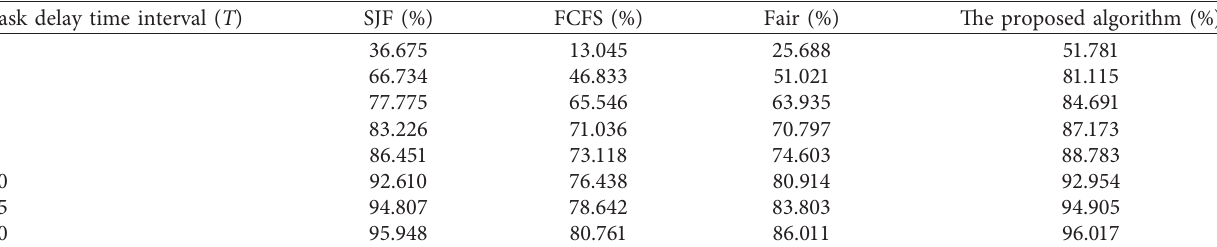
Table 5: The task distribution in different delay time intervals.